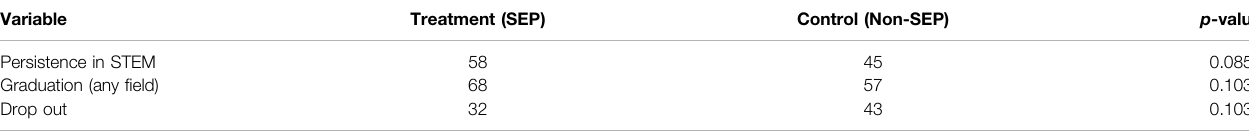
TABLE 4 | Descriptive Statistics: Graduation, STEM Persistence, and Drop-out. By Dina Ghazzawi, Donna Pattison, and Catherine Horn. Variable